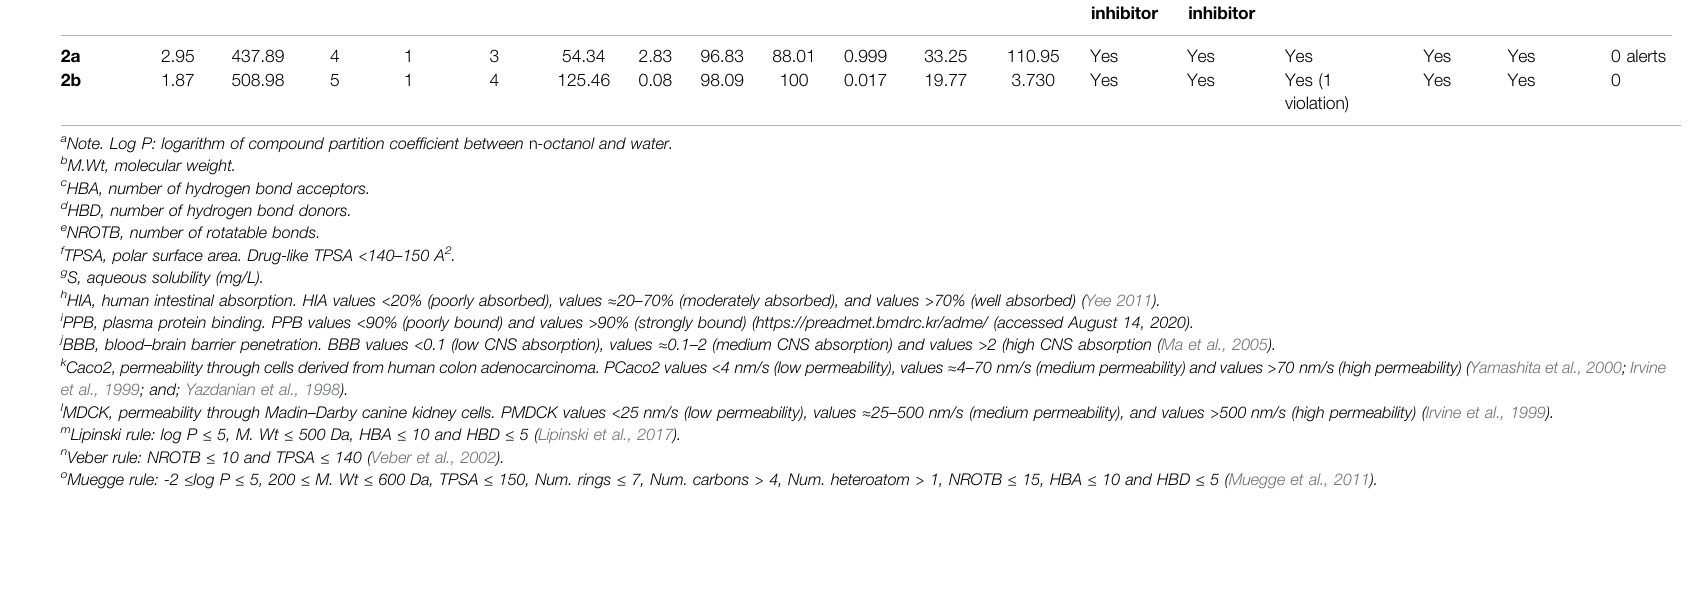
TABLE 6 | In silico predicted physicochemical properties, ADMET, and drug likeness of the spirooxindoline derivatives 2a and 2b . Cpd. Physiochemical parameters ADME Bioavailability and drug No